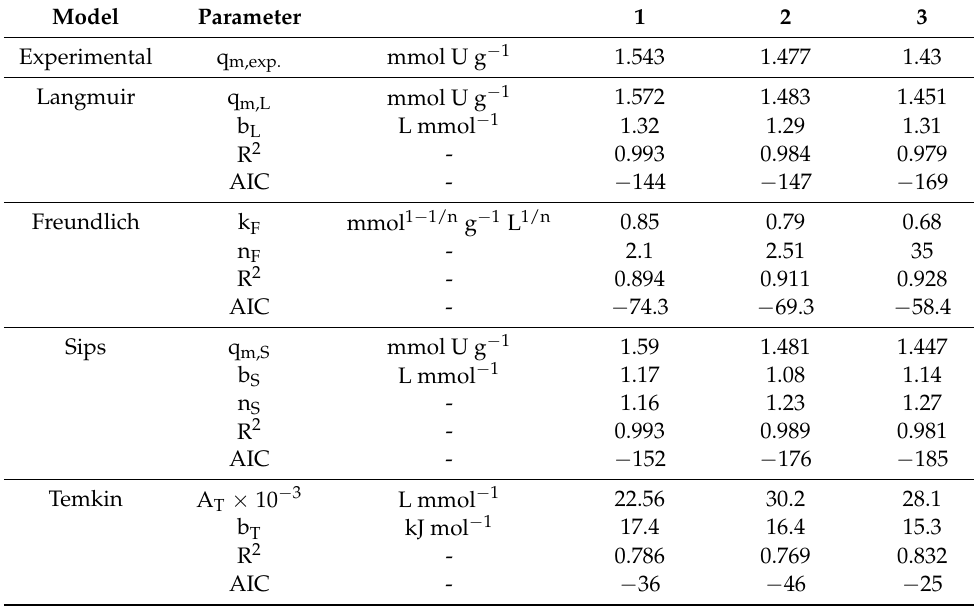
Table 5. Modeling of U(VI) sorption isotherms.